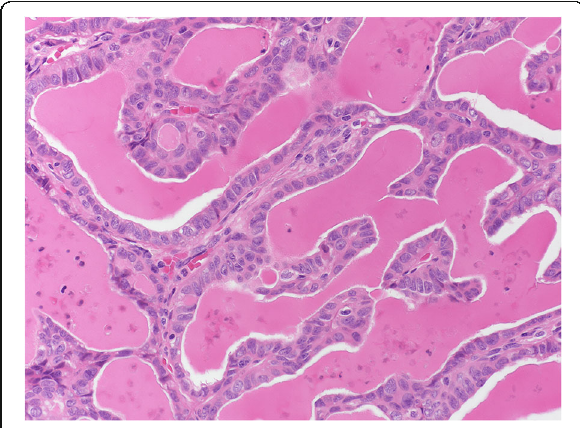
Fig. 6 Thyroid-like follicular renal cell carcinoma. In this tumor the follicles are more irregular and there is more pronounced nuclear